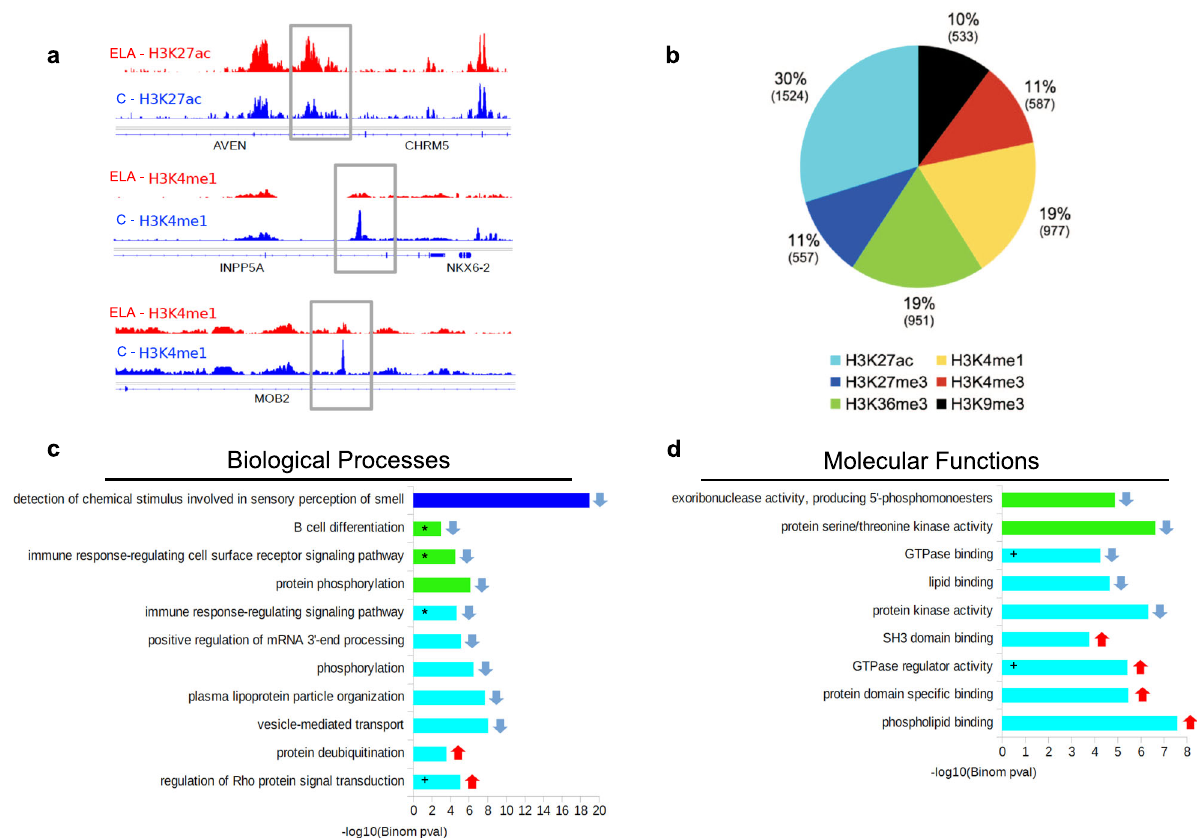
Fig. 3 Analysis of genomic sites showing differential enrichment for individual histone marks in subjects with a history of early-life adversity (ELA). a Representation of three top Differential Sites (DS), identi fi ed using diffReps 34 . ELA is shown in red, healthy controls (C) are shown in blue. Gray rectangles delineate the coordinates of each DS. b Relative proportion of DS contributed by each histone mark. Percentages of the total number of DS, and absolute number of DS (in brackets) are shown for each mark. Both depletion- and enrichment-DS were observed for each of the six marks (Supplementary Fig. 12b). Among genes most strongly affected (Supplementary Table 5), several have been previously associated with psychopathology, such as QKI (H3K27ac top hit) 40,95 or HTR1A (H3K4me3 top hit) 96 . c , d Top fi ve most signi fi cant non-redundant gene ontology “ Biological Processes ” ( c ) or “ Molecular Functions ” ( d ) terms enriched for each histone mark DS, as identi fi ed by GREAT 36 using hypergeometric and binomial testing (fold change ≥ 1.5 and FDR-q ≤ 0.1 for both tests). Surprisingly, the single most signi fi cant result implicated epigenetic dysregulation of odor perception in ELA subjects (consistent with recent clinical studies 97 ), while immune processes (indicated by *), and small GTPases ( + ) were consistently found affected across different marks. Negative logarithmic P values are shown for binomial testing. The color indicates histone mark concerned, arrows indicate the direction of event: terms associated with depletion- (down arrow) or enrichment-DS (up arrow). Source data are provided as a Source Data fi